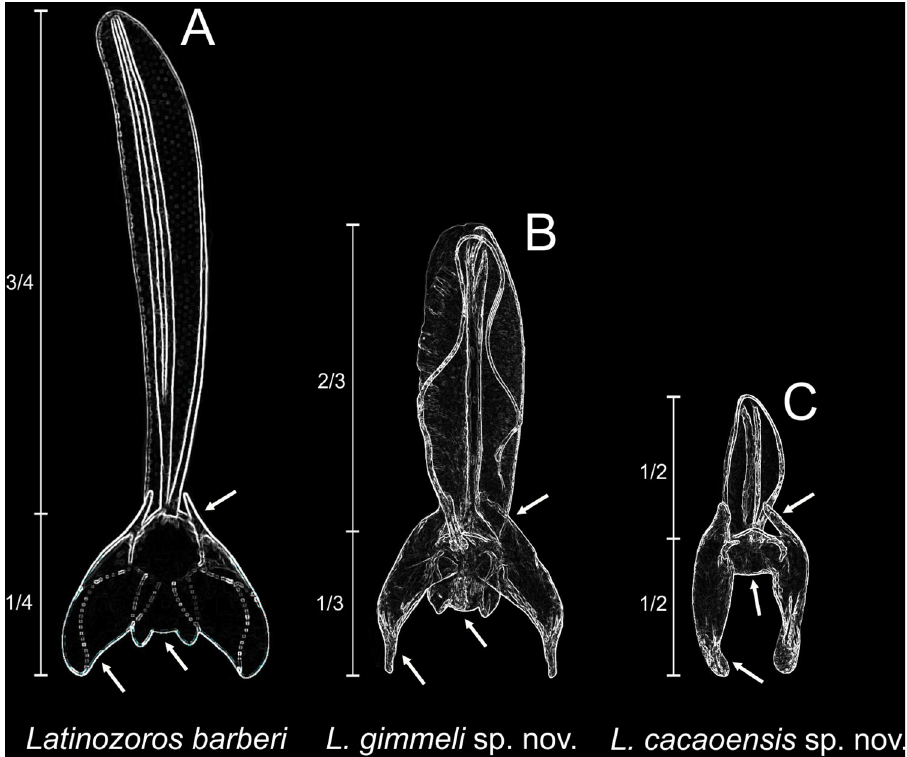
Fig 8. Characters of male genitals useful for the identification of Latinozoros barberi (Gurney, 1938) [30], L . gimmeli sp. nov., and L . cacaoensis sp. nov. The drawing of the male genital of L . barberi is adopted from Gurney (1938); the depicted male genitals of L . gimmeli sp. nov. and L . cacaoensis sp. nov. are original photographs that were improved by highlighting the edges using the filter “glowing outlines”in Photoshop CS6 Extended v13. Dorsal sclerites are masked for better visibility of important characters.